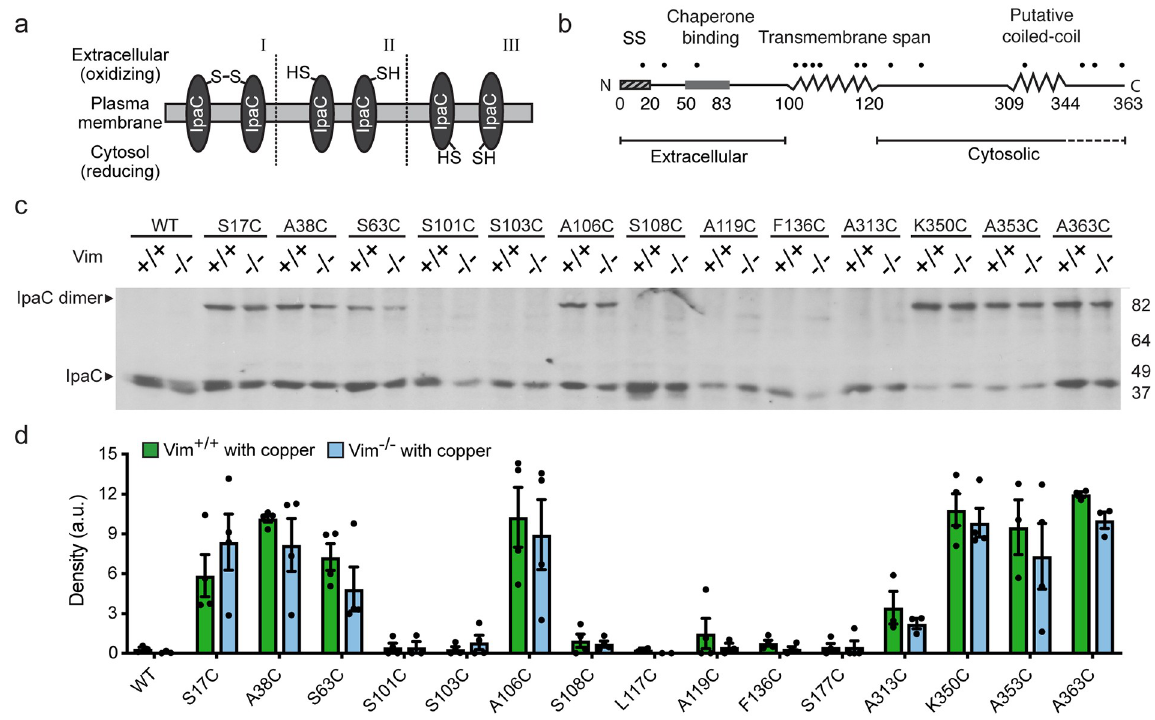
Fig 1. In membrane-embedded translocon pores, individual IpaC molecules are adjacent to one another. (a) Schematic of the dependence of disulfide bond formation on an oxidative environment and the relative positioning of free sulfhydryl groups. Disulfide bond formation occurs when residues are located in the extracellular space, and when in close proximity with the correct orientation of the residues in adjacent molecules [I]. The formation of disulfide bonds is not efficient when residues are in an oxidative environment but are not in proximity or correctly oriented [II], or when residues are in a reducing environment, such as the cytosol [III]. (b) Schematic of secondary structure and orientation in the membrane of IpaC protein. Dots indicate the relative position of the mutants tested. Dashed line beneath residues 344–363 reflects the accessibility of these residues to the extracellular milieu [23], suggesting that they loop into the pore lumen. (c-d) Analysis of intermolecular crosslinking of single cysteine substitutions of IpaC delivered to cells during S . flexneri infection. Infection of Vim +/+ or Vim -/- MEFs in the presence of the oxidant copper with strains of S . flexneri Δ ipaC producing individual IpaC cysteine substitutions. Representative western blot of IpaC, showing bands migrating at the molecular weight of IpaC dimers and monomers ( c ). Densitometry of the ~80 kilodalton band from three to four independent experiments; mean ± SEM ( d ). For cysteine substitution derivatives, band densities are not significantly different for infection of Vim +/+ versus Vim -/- MEFs.